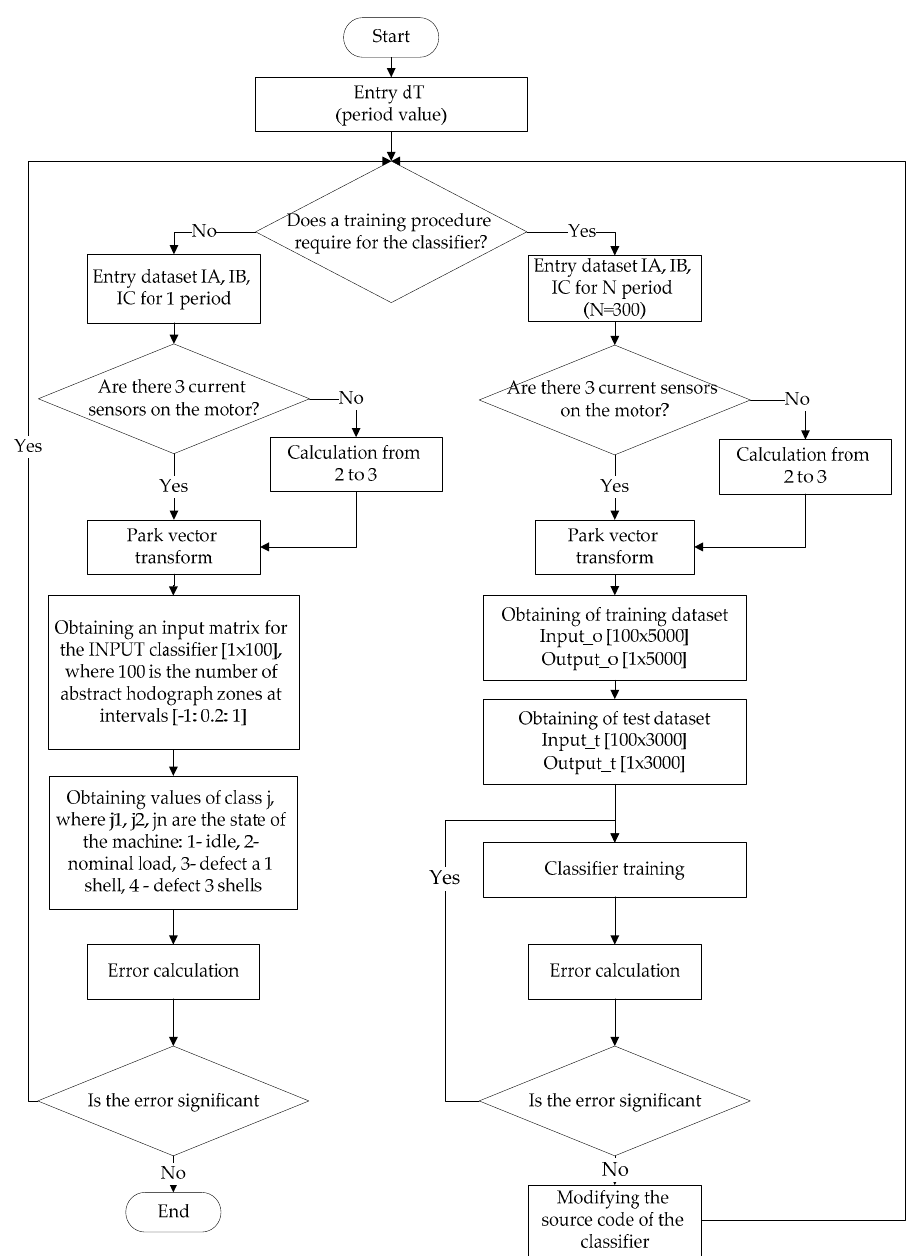
Figure 2. The algorithm for ANN classifier.